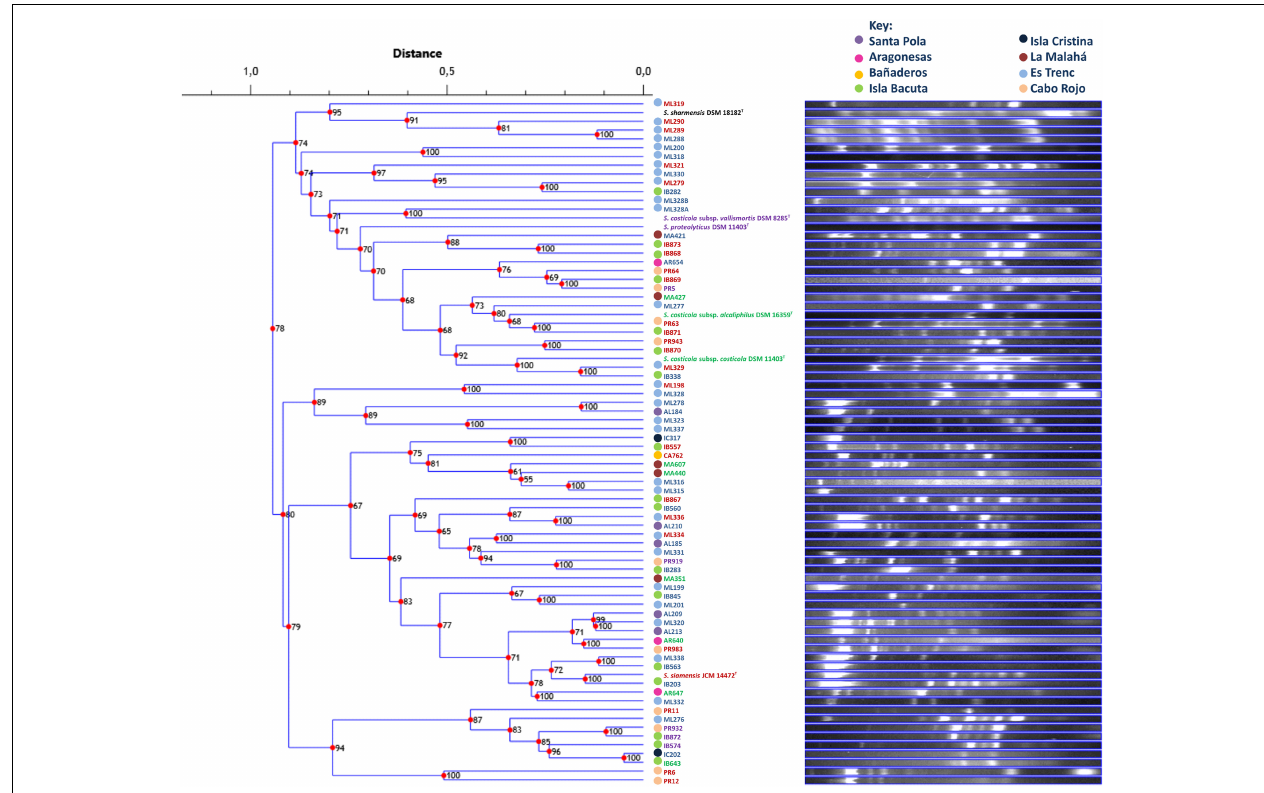
FIGURE 6 | UPGMA dendrogram comparing banding patterns between isolated and type strains of the genus Salinivibrio . The numbers displayed at the nodes represent the cophenetic correlation coefficients. Each place of isolation is represented with a circle of different color. Strain names are colored according to the phylogroup they belong